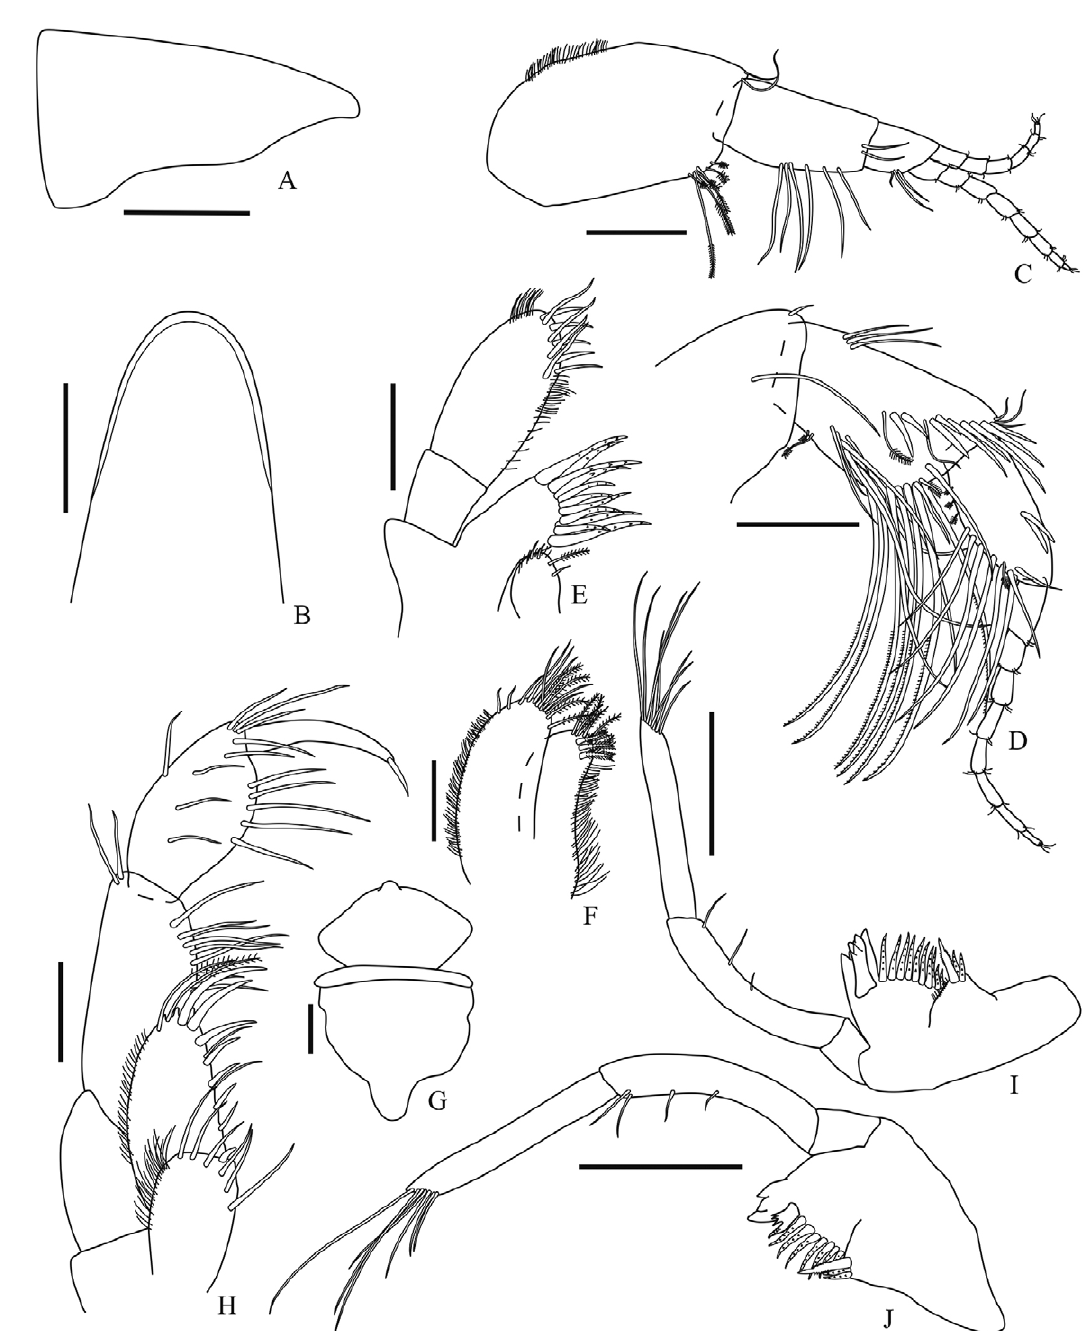
Fig. 2. – Atlantiphoxus wajapi n. sp. holotype female (UERJ 401). A, head in lateral view; B, head in dorsal view; C, antenna 1; D, antenna 2; E, maxilla 1; F, maxilla 2; G, upper lip; H, maxilliped; I, left mandible; J, right mandible. Scale bars: A-D and I-J: 0.2 mm, E-H: 0.1